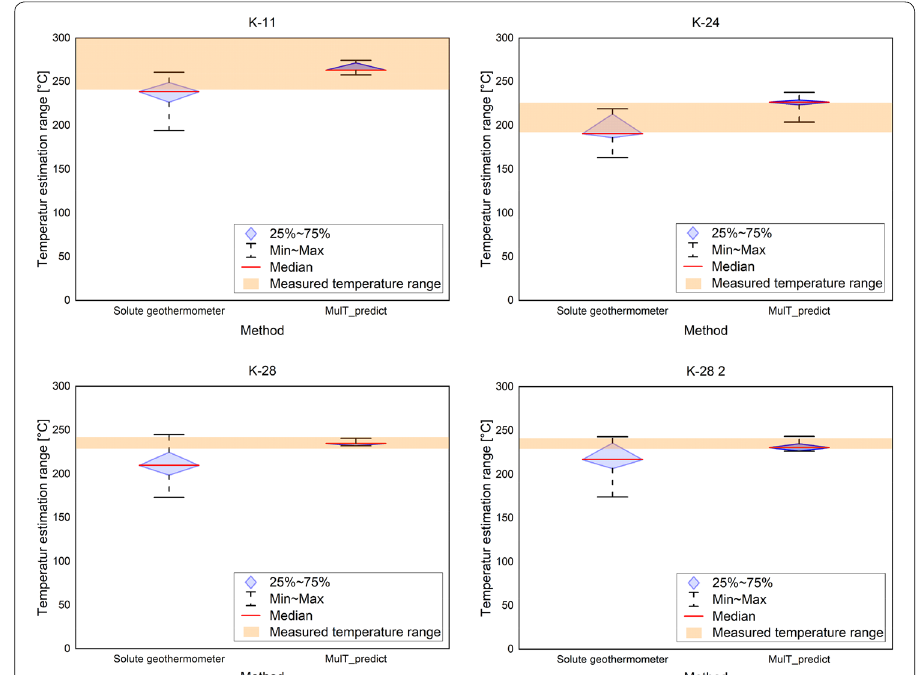
(Fig. 7) for the wells at